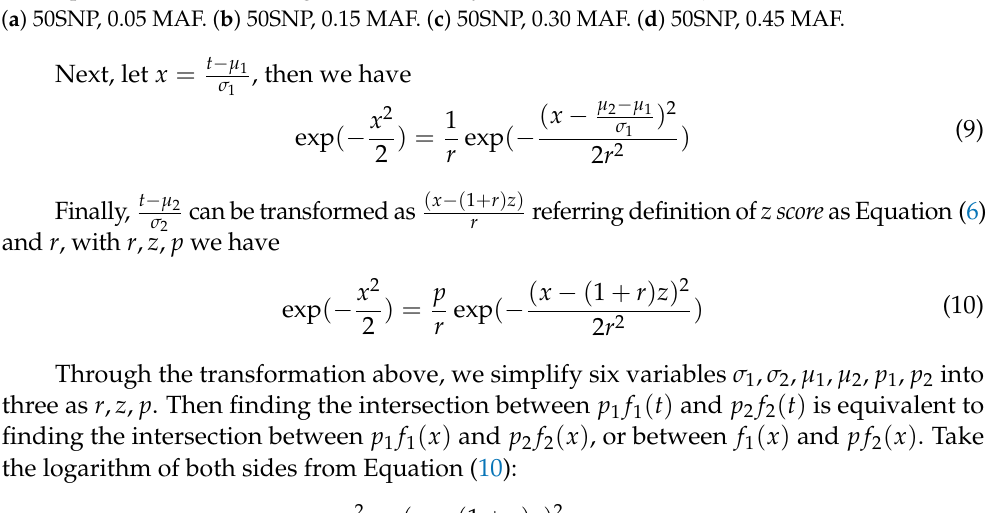
Figure 4. True-positive and false-positive for varying F score with SNP size 50 and z score 2.33 . The abscissa values is F score , and the ordinate is metrics as percentage. Solid and dotted lines represent true-positive and false-positive, respectively. Different colours signify different sample sizes n , where orange represents n = 50, red represents n = 100, olive represents n = 200, and blue represents n = 500. Subfigures successively indicate MAF values p as 0.05, 0.15, 0.30, and